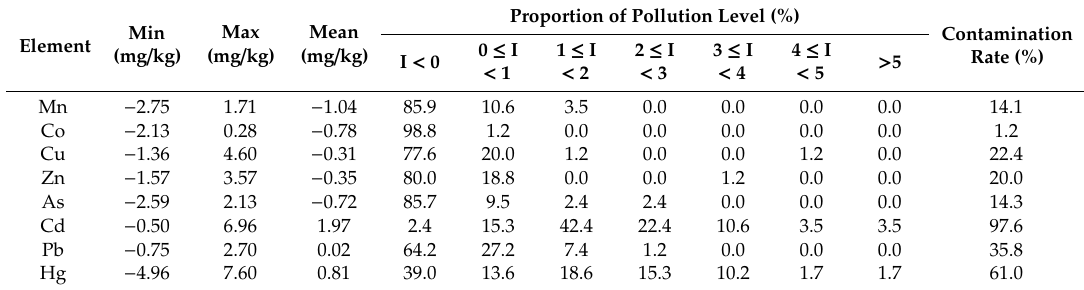
Table 4. Evaluation of geo-accumulation